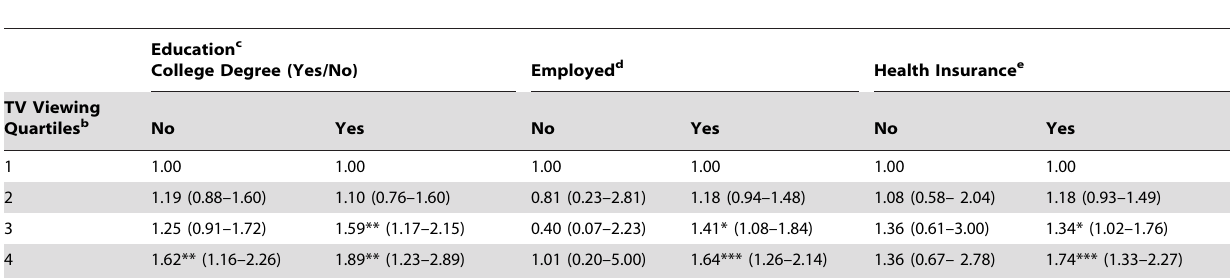
Table 3. Multivariate Ordered Logistic regression a for overweight/obesity according to TV viewing Stratified by Education, Employment, and Health